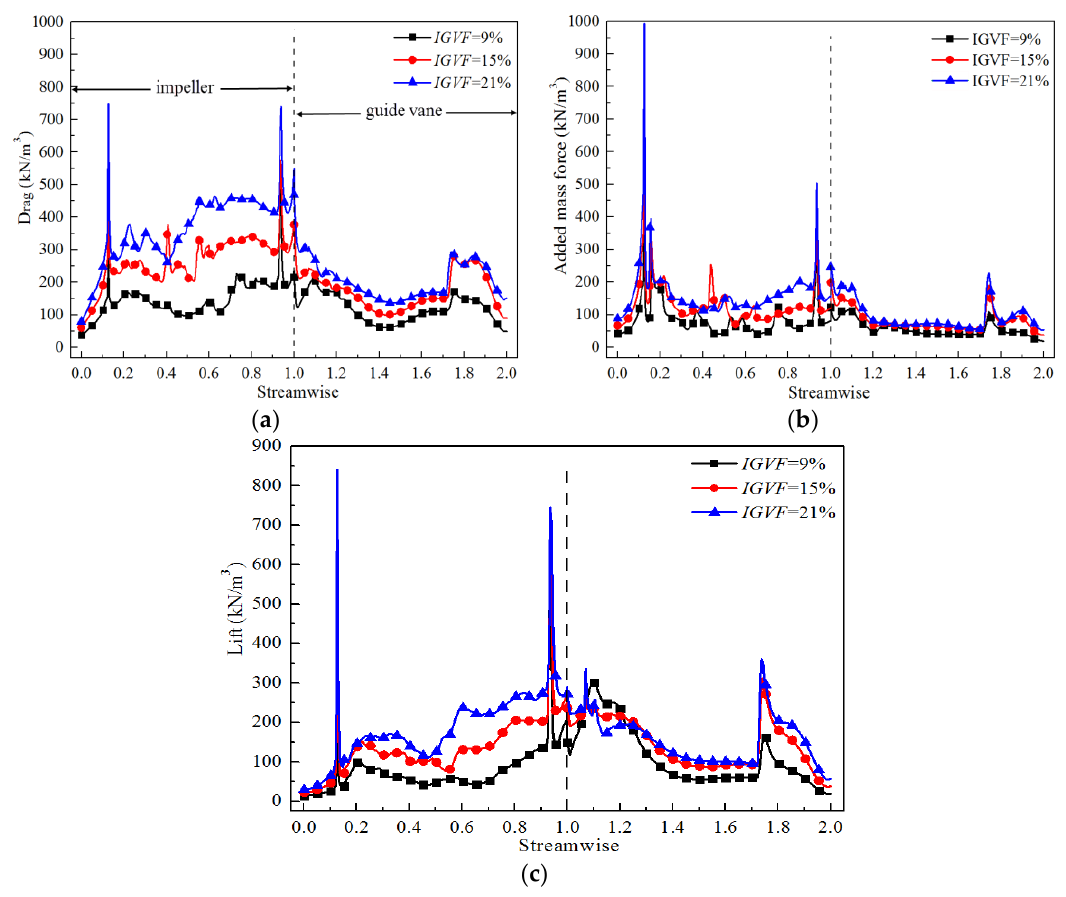
Figure 6. Distribution of interphase forces along the streamwise direction at different IGVF s. ( a ) Drag force; ( b ) Added mass force; ( c ) Lift force.